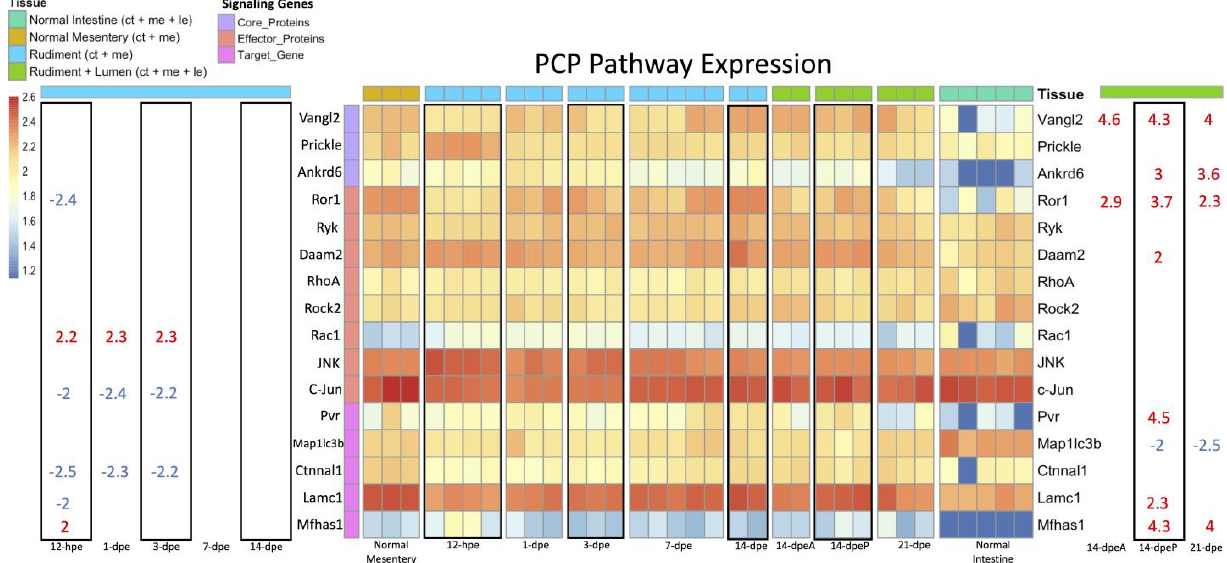
Figure 8. Heatmap of the signaling genes in the Wnt/PCP pathway. This figure is read the same as in Figure 5. The significance threshold remains the same. The only difference is that the rows are color coded to indicate the role of the gene in the Wnt/PCP pathway. Genes labeled as Core Proteins are unique and essential to the Wnt/PCP pathway and, therefore, are strong indicators of its presence. The effector proteins are genes involved in carrying out the signaling cascade, while target genes are activated by the transcriptions factor c-Jun.